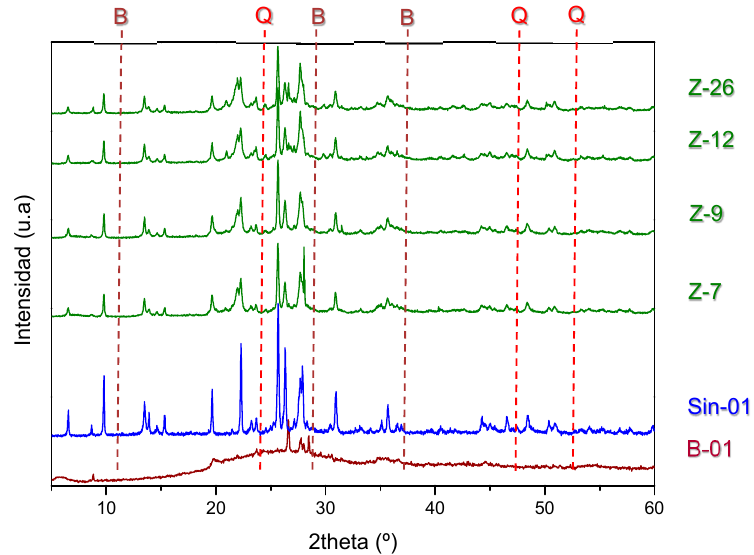
Figure 2. X-ray diffraction patterns of the natural mordenites from Spain (Z-7 to Z-26), commercial synthetic mordenite (Sin-01), and the bentonite host rock (B-01). Other mineral phases of bentonite (smectite) are market with “B” and quartz with “Q”.